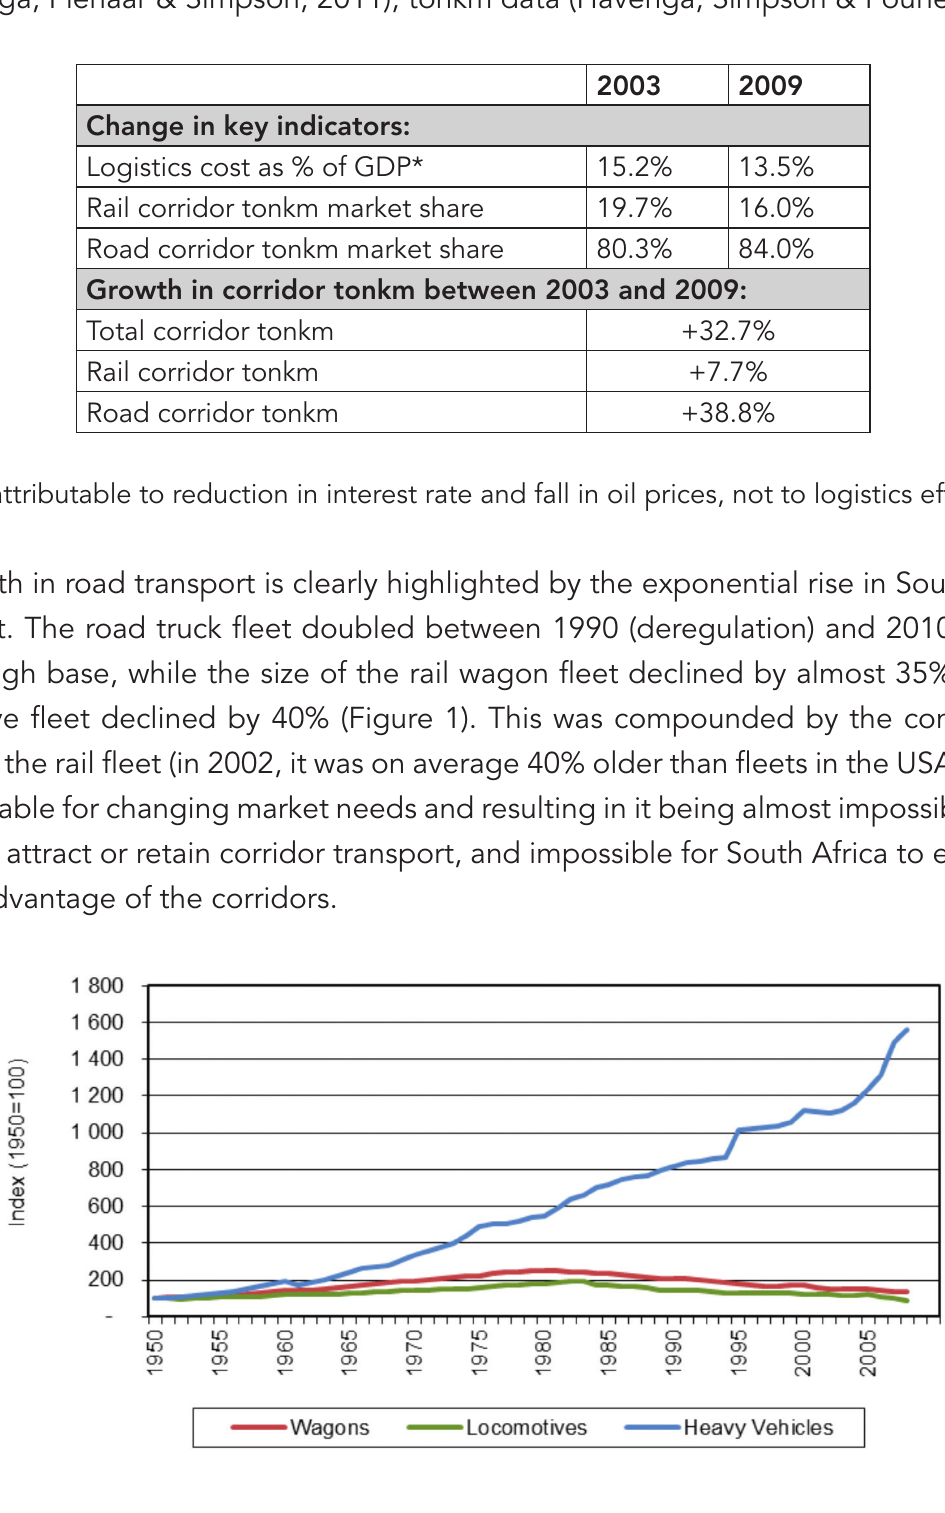
Figure 1: Growth in heavy vehicle population (eNatis, 2011) compared to rail wagons and locomotives (Transnet Freight Rail,